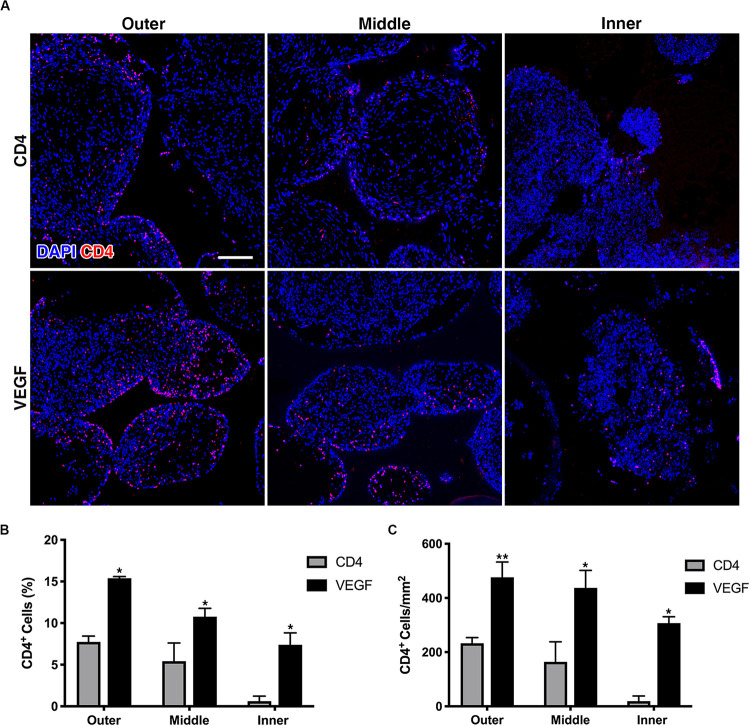
(A) Representative immunofluorescence images from the outer, middle and inner layers of graft sections stained for rbCD4 (red) to detect the seeded progenitors and counterstained with DAPI (blue) to label nuclei (size bar = 100 μm); (B,C) quantification of the number of CD4+ cells, expressed as percentage (%) of the total cell number (B) and as absolute number per mm2 of tissue area (C) in each layer (n = 4, *p < 0.05, **p < 0.01).